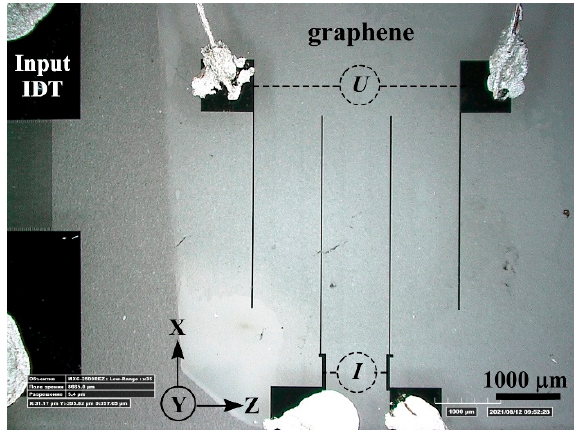
Figure 1. Optical image of the SAW delay time line with graphene.